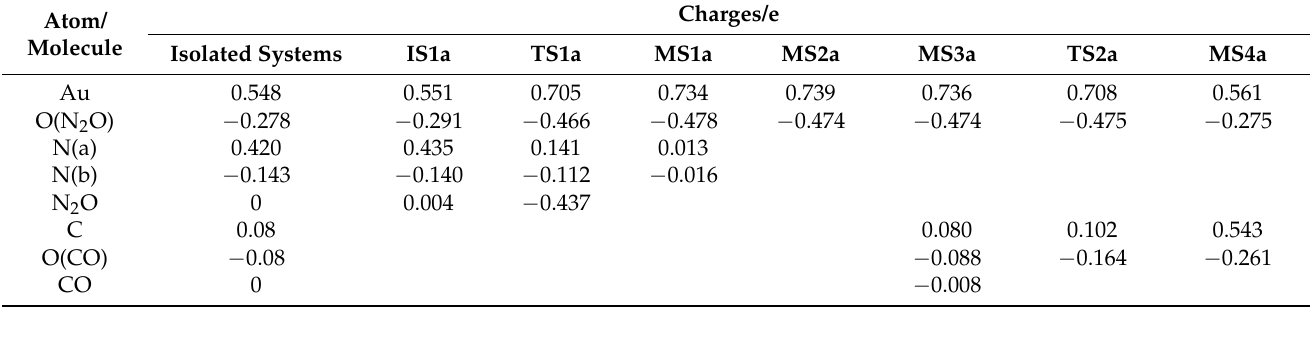
Table 2. The Mulliken charge of species involved in Au/C 2 N catalytic N 2 O reduction mechanism I. N(a) represents the N atom bonding with O atoms, and N(b) represents the ending N atom in N 2 O.